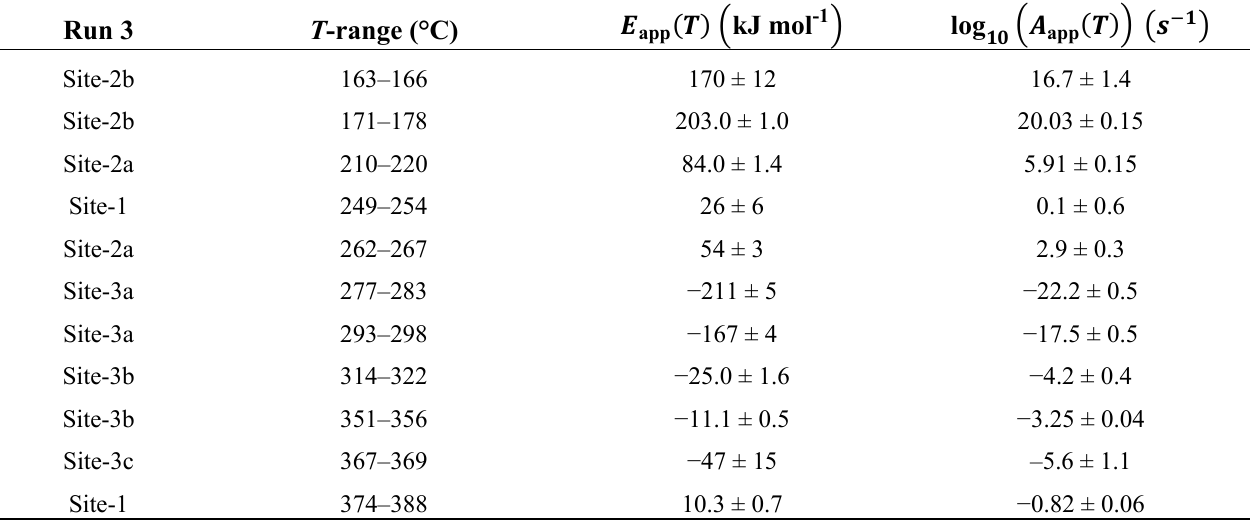
Table 3. Average apparent activation energies and prefactors for each peak, plateau and shoulder in Figure 3. Site-1 are assigned to isobutene desorption. Site-2a and Site-2b are isobutane dehydrogenation and Site-3a, Site-3b and Site-3c are isobutene dimerization